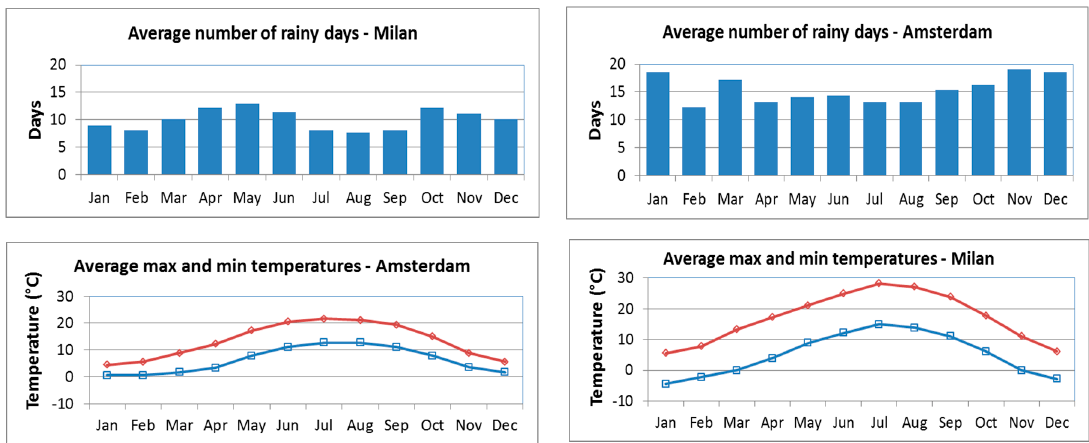
Figure 2. Number of rainy days per month in Milan ( top left ) and Amsterdam ( top right ) and monthly average of the maximum and minimum temperature in Milan ( lower left ) and Amsterdam ( lower right ) (data from [33]).